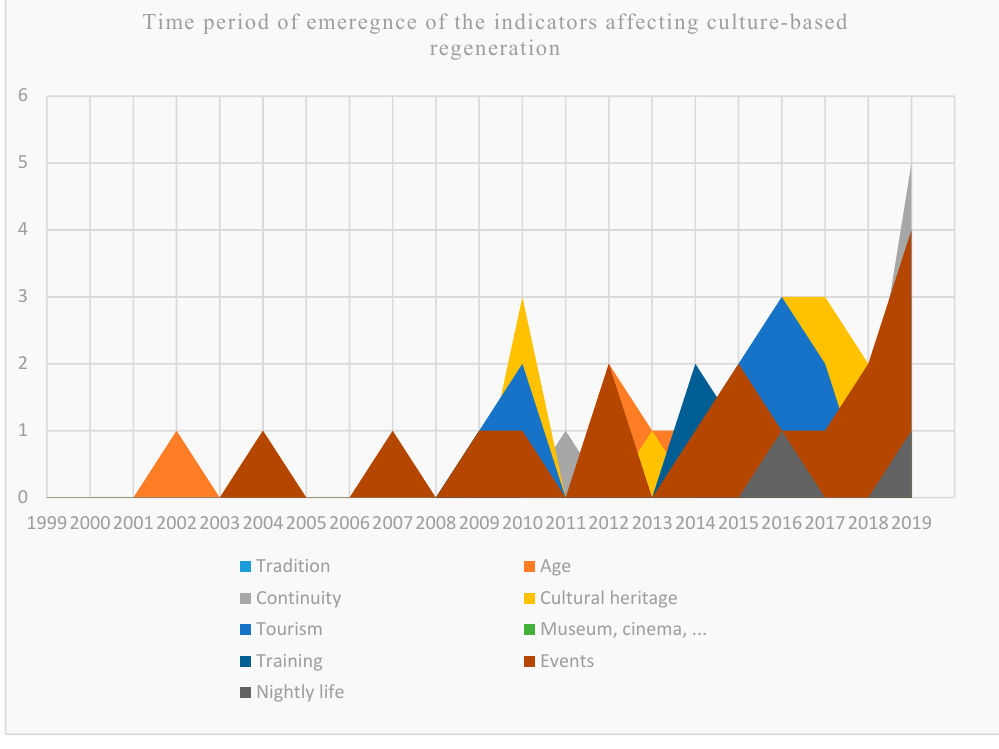
Figure 8. Time period of emergence of the indicators affecting culture-led regeneration.